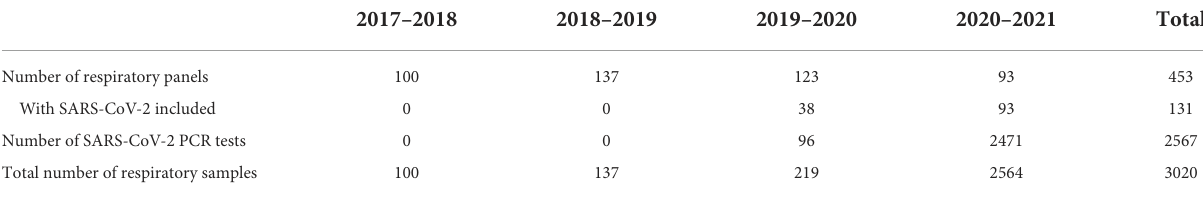
TABLE 1 Total number of respiratory samples included in this study.